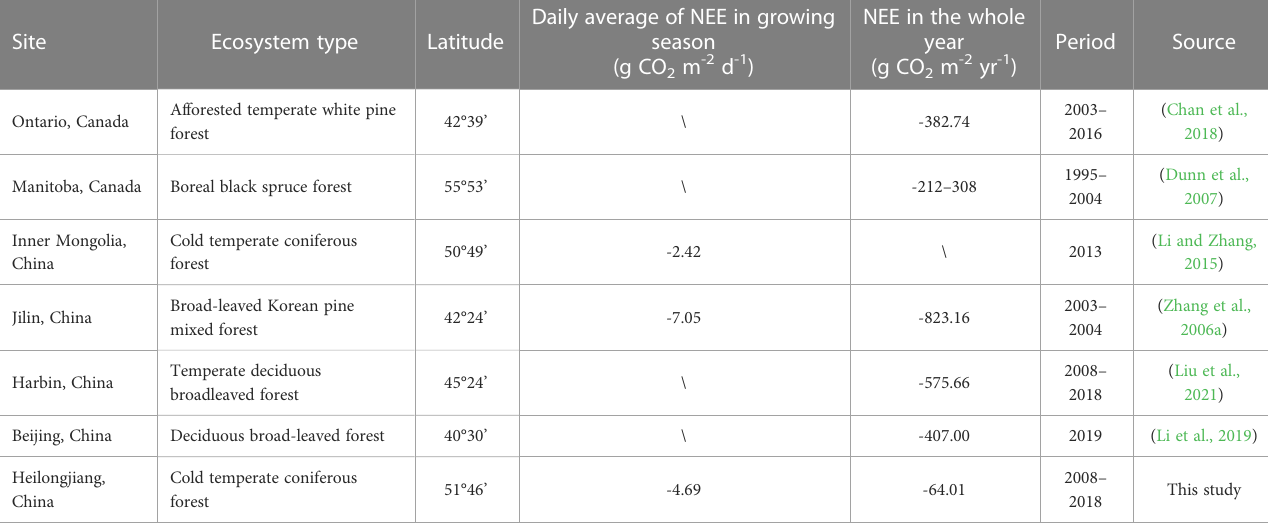
TABLE 5 Comparison of growing season and annual CO 2 budget among diverse forest ecosystems.